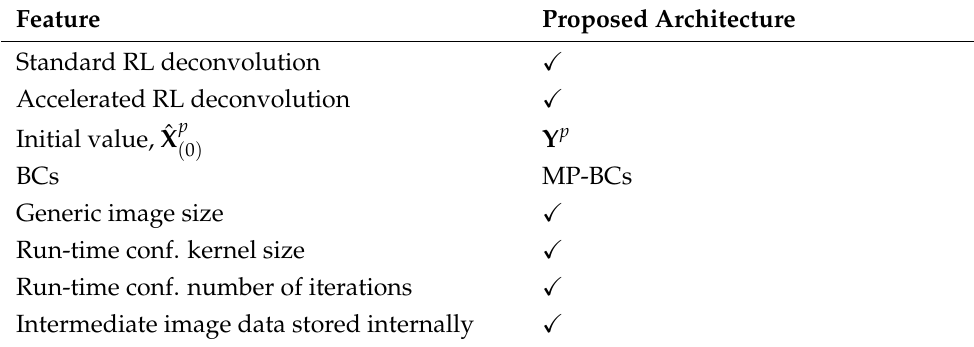
Figure 11. A generalized block diagram for the proposed architecture. Table 4. Feature summary for the proposed